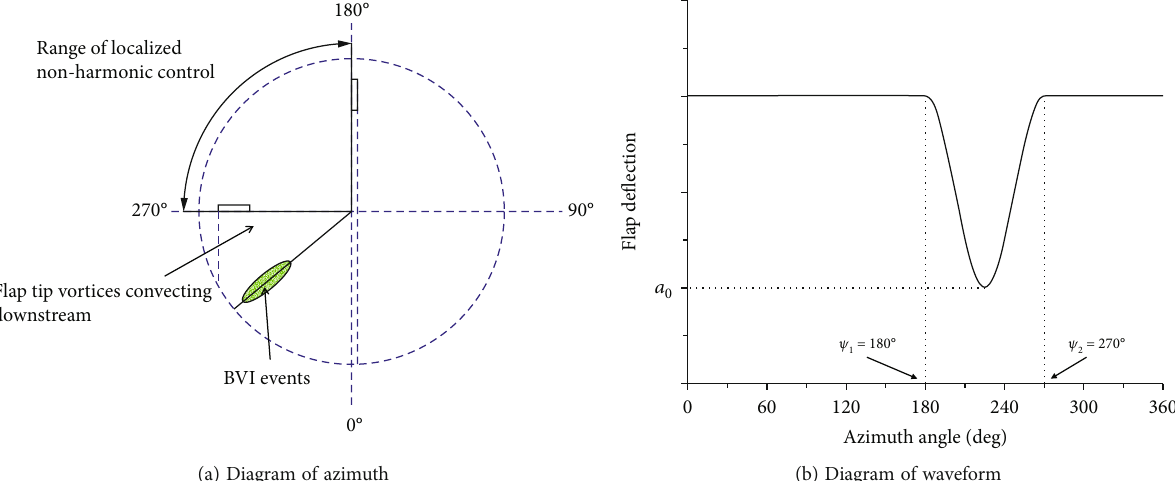
Range of localized non-harmonic control